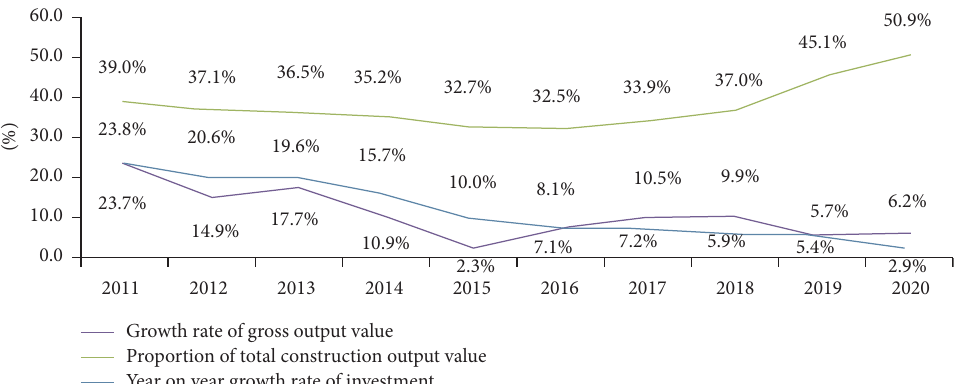
Figure 3: Gross output value and growth rate of construction industry. Source: National Bureau of Statistics (NBS)